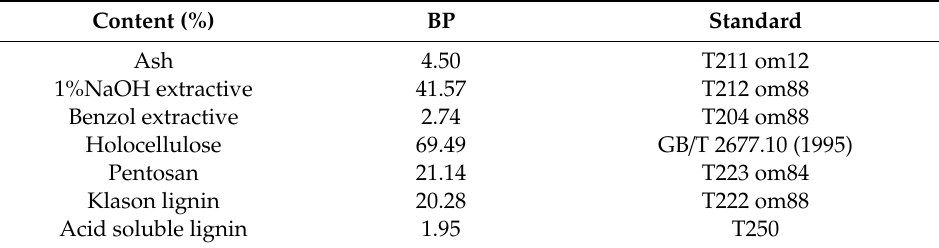
Table 1. Chemical composition of bagasse pith